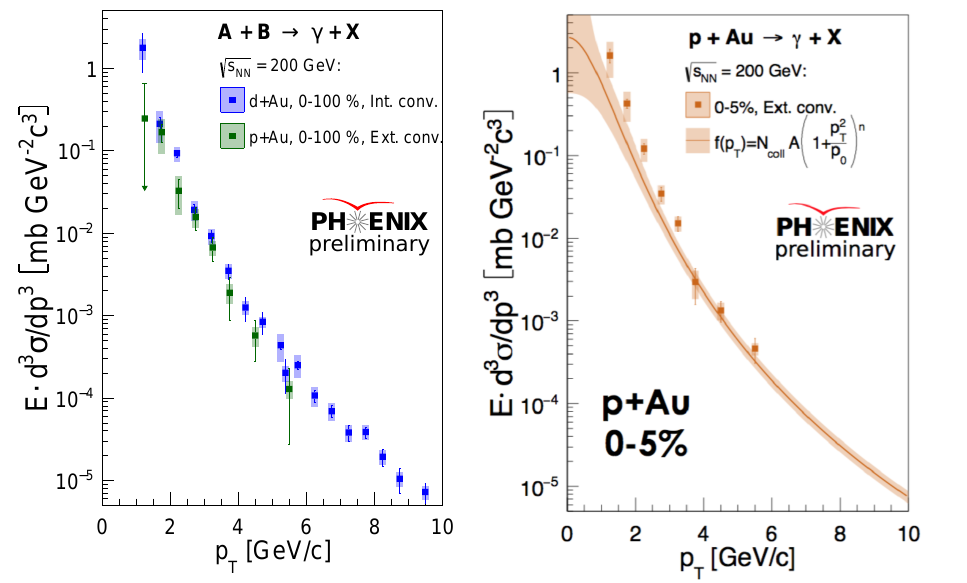
Figure 3. Direct photon yield at low p T in d+Au and p+Au MB ( left ), and p+Au central collision at 200 GeV ( right